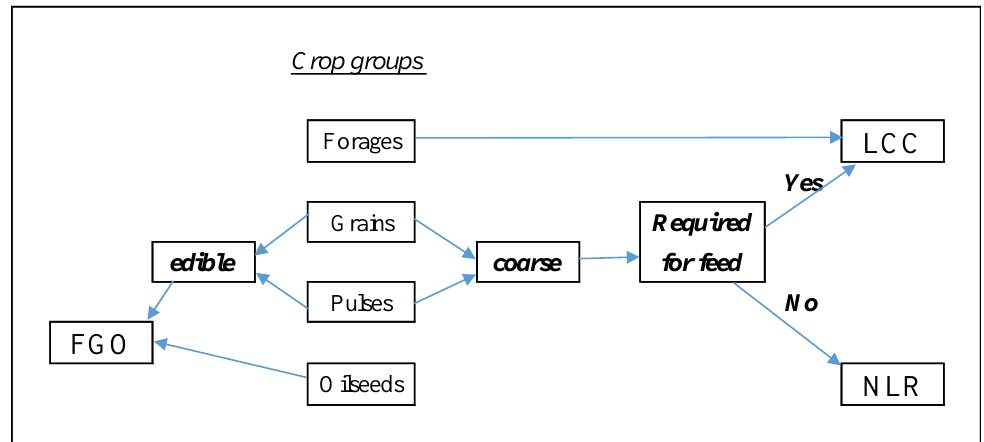
Figure 1. Org-chart showing the classifications of the four field crop groups grown in Canada based on their uses among the three land use categories, including the Livestock Crop Complex (LCC), Food Grains and Oilseeds (FGO) and the Non-Livestock Residual (NLR).